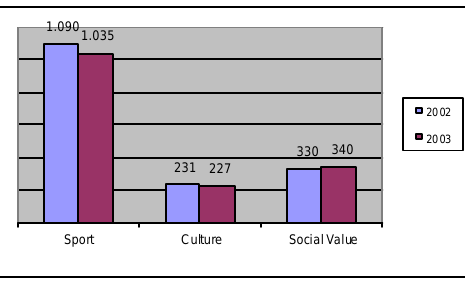
Figure 5: Sponsorship Trends in Italy by Market Segment (in Millions of